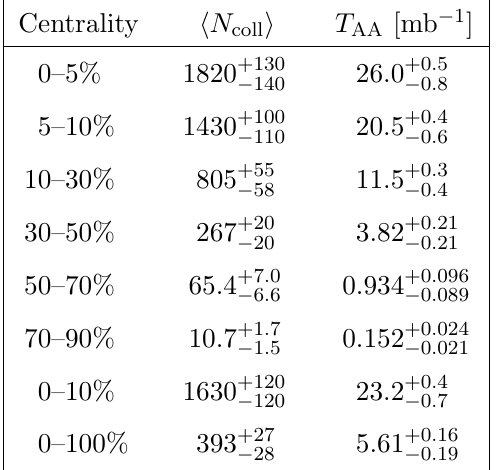
Table 1 . The values of h N coll i and T AA and their uncertainties in for the centrality ranges used in this